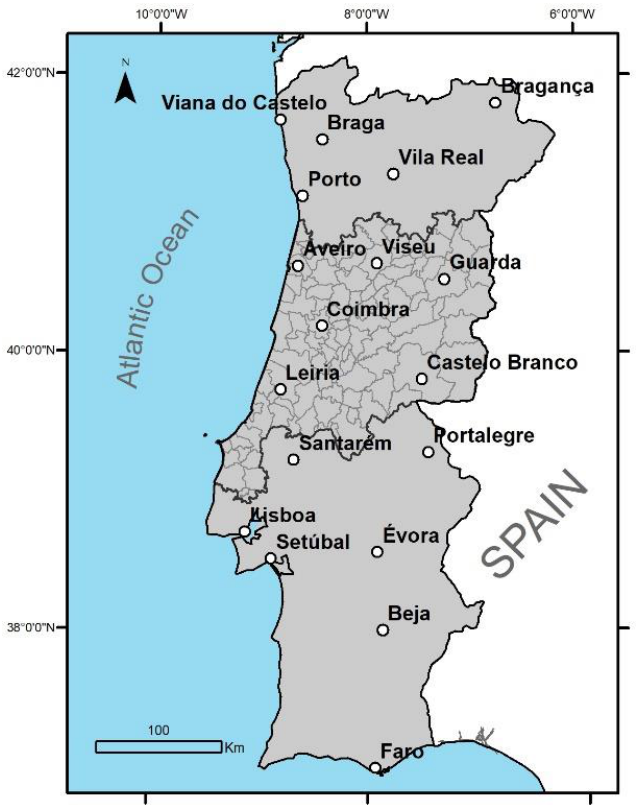
Figure 1. Location of the study area in relation to mainland Portugal and its main cities. Municipal limits within the study area are shown in light grey.